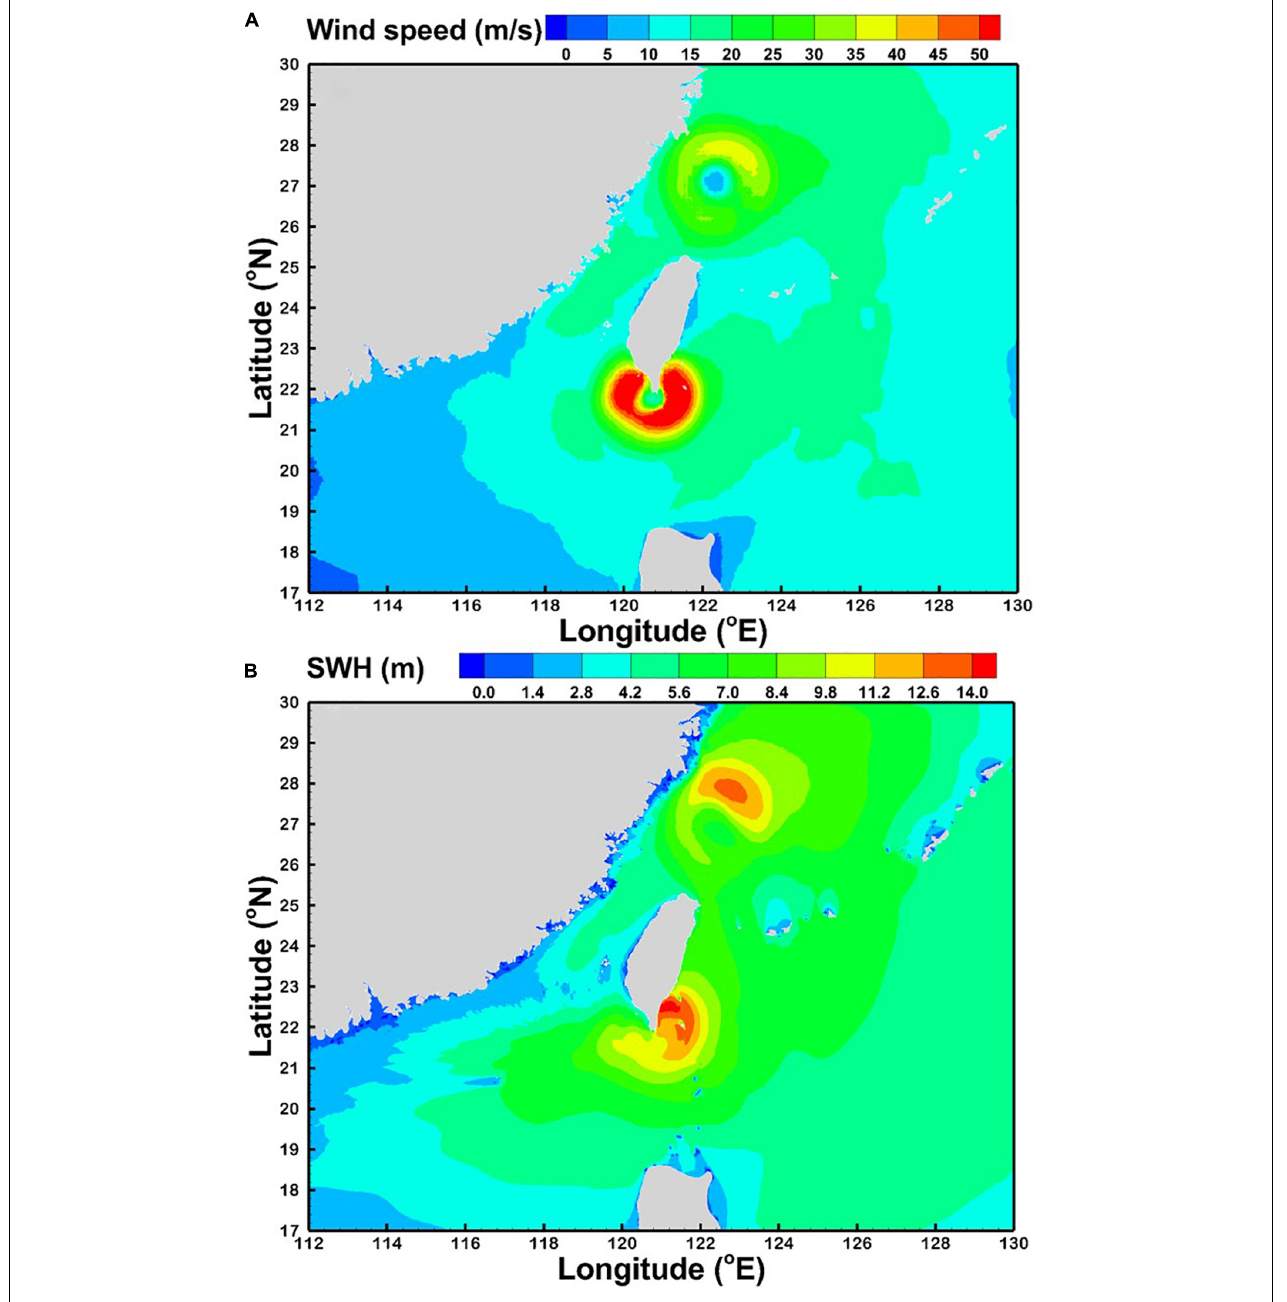
FIGURE 8 | Spatial distribution of (A) the instantaneous wind field from a superposition of Super Typhoons Lekima in 2019 and Meranti in 2016 and (B) the corresponding significant wave heights.